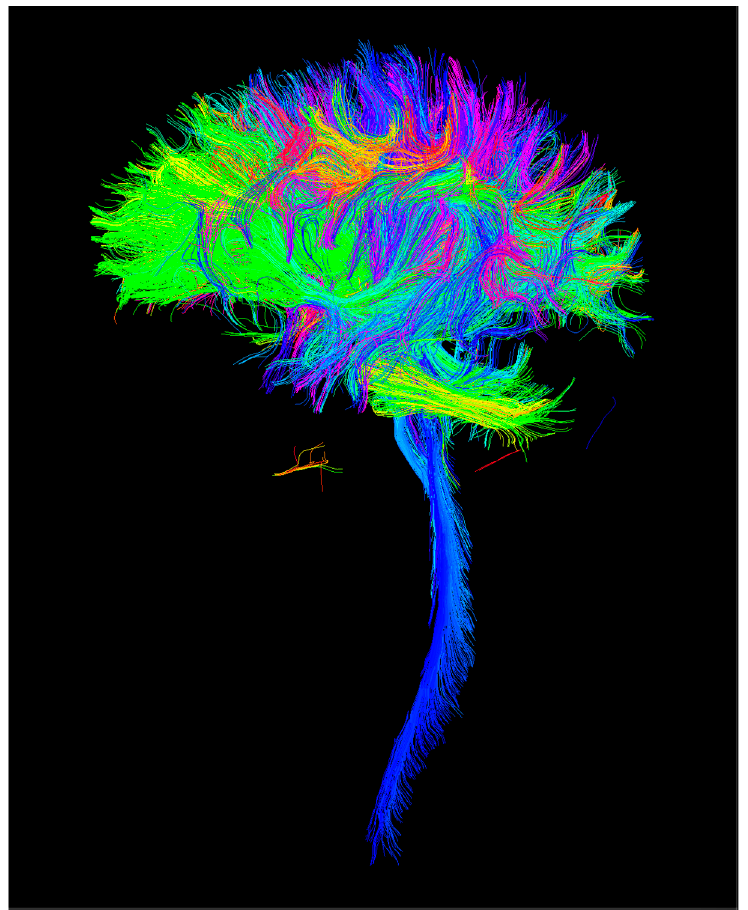
Figure 4. Sample case of whole brain tractography from the diffusion MRI data.